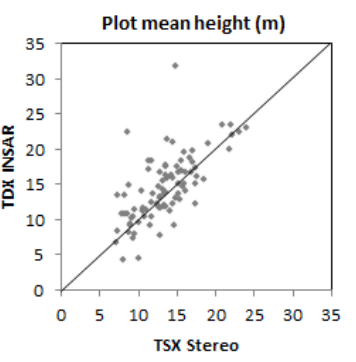
Figure 3. Plot mean height from TSX data vs. plot mean heights from TDX data. Line in the figure is one-to-one line.